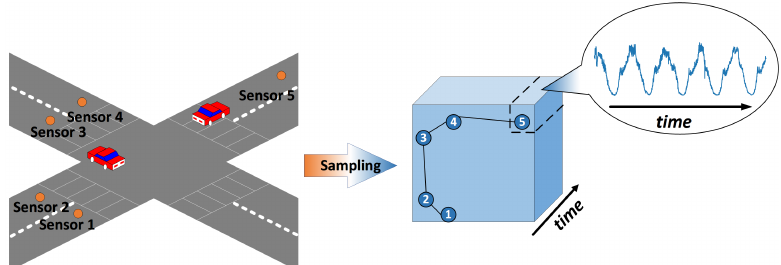
Figure 1. Complex spatial and temporal dependencies. The traffic network data are sampled as traffic graph signals, which consist of many sets of traffic node signals and the nodes are interrelated as a graph. The temporal dependencies of each set of node signals represent the seasonality and trend. The predetermined graph structure could easily go wrong such as nodes 1 and 2 (false connection), nodes 2 and 5 (missing